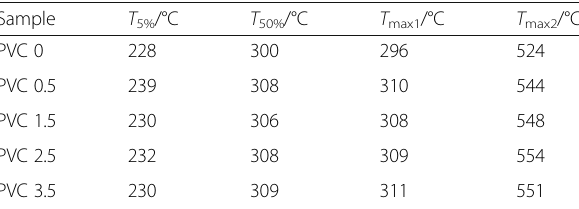
Table 2 Thermogravimetric data of flexible PVC and PVC-matrix composites in air atmosphere